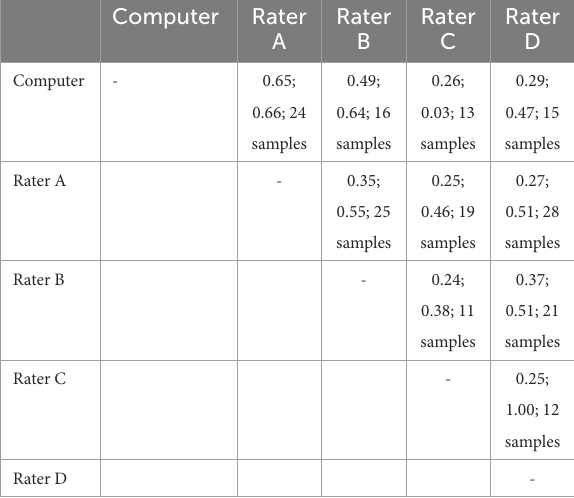
TABLE 5 Mann-Whitney-U rank-sum tests for the different topics and groups (low and high text